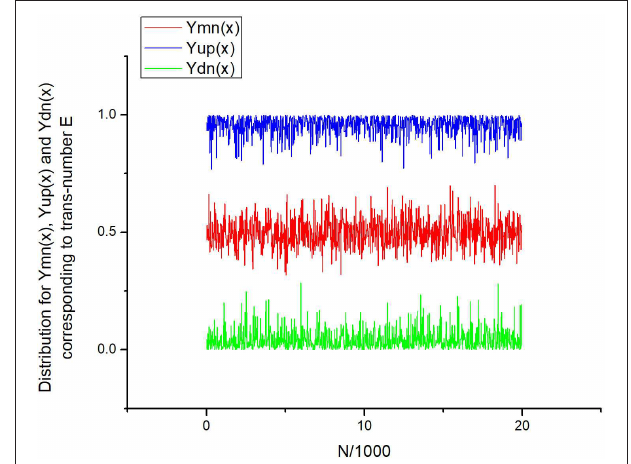
FIGURE 5 | Three distributions of the initial “ideal” noise obtained for the transcendental number E , with the initial sequence compressed by the factor b = 20 and containing only 1,000 data points. They form three initial random sequences that can be transformed into three 3D-surfaces for identification of their differences and formation of a specific “fingerprint.” Visually, this noise looks like the “ideal” noise depicted in Figure 1 .